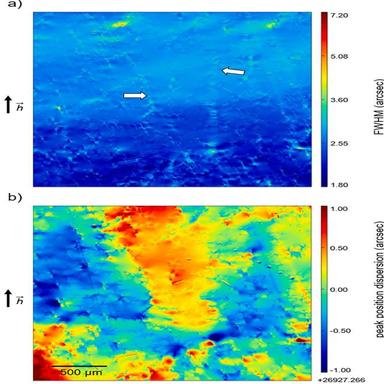
RCI maps of GaN substrate (1120 reflection, 30 keV) a) the FWHM map shows aligned dots of threading dislocations, two of the alignments being indicated by arrows b) the Peak Position map shows that these aligned dislocations act as geometrically necessary ones for the subgrain arrangement that is clearly visible, with misorientations in the second of arc range. Image size: 2.5 × 2.5 mm2 .